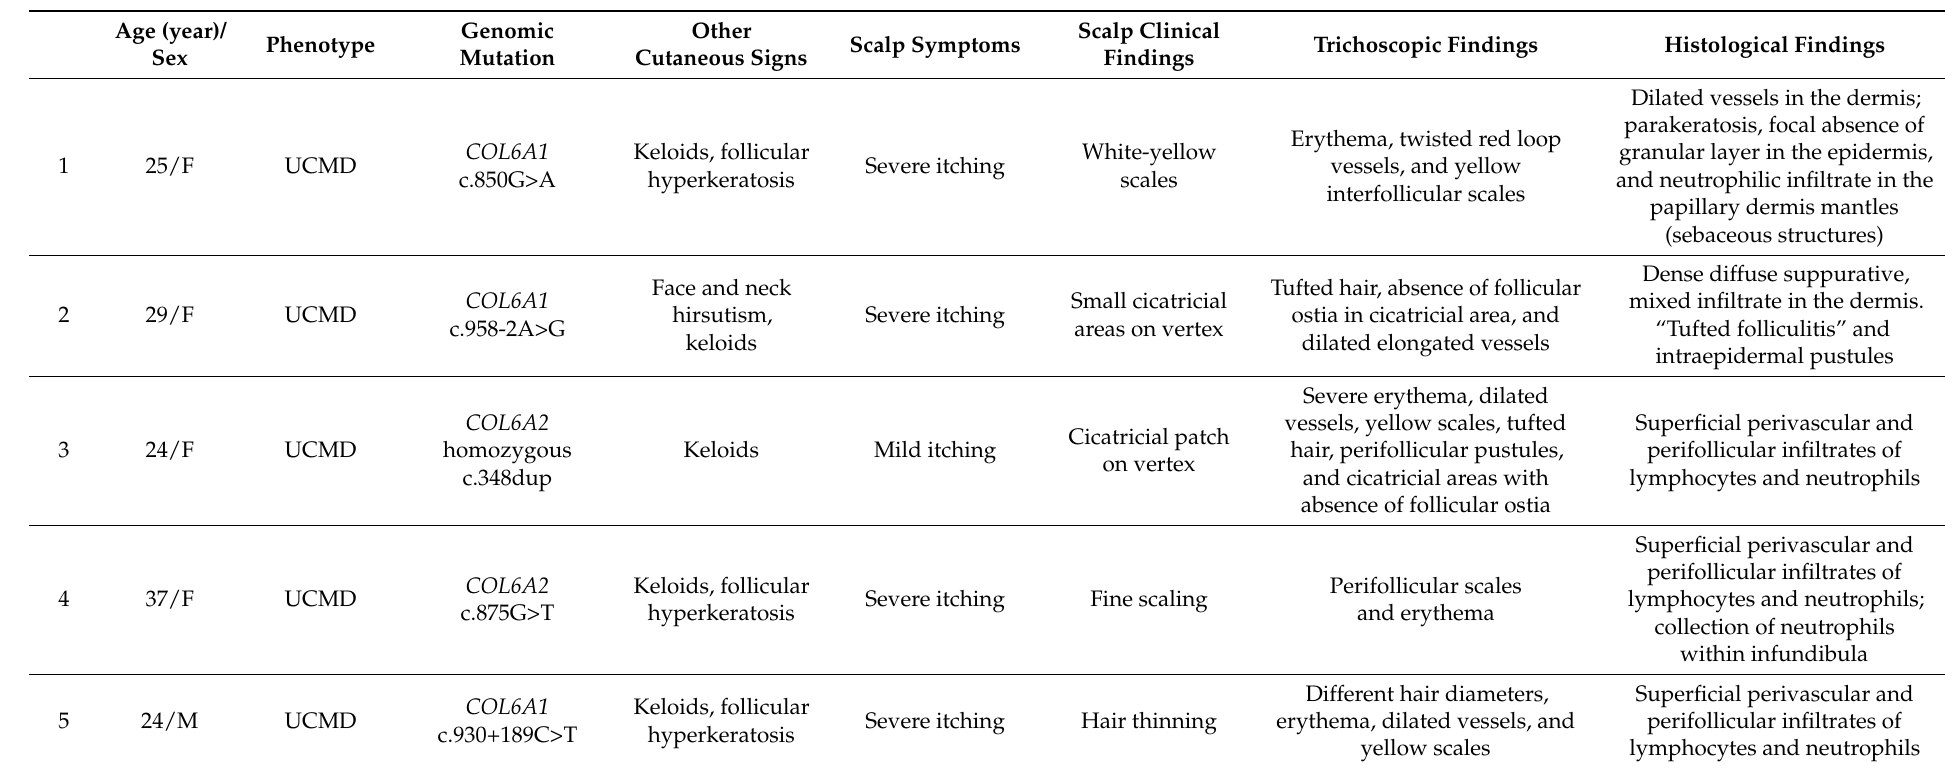
Table 1. Demographic, clinical, genetic, trichoscopic, and histological characteristics of